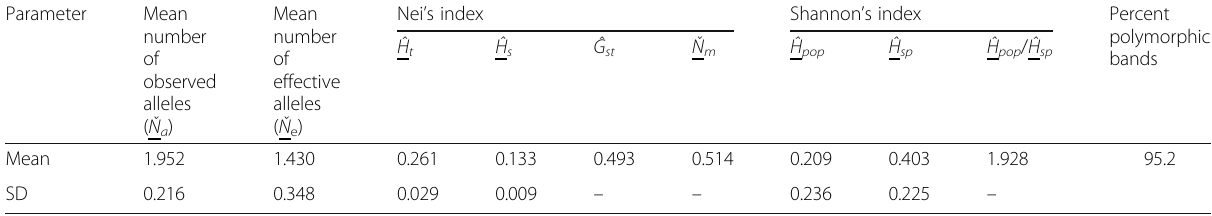
Table 6 Overall genetic variability statistics, assuming Hardy-Weinberg equilibrium for the different growth forms of D. strictus Parameter